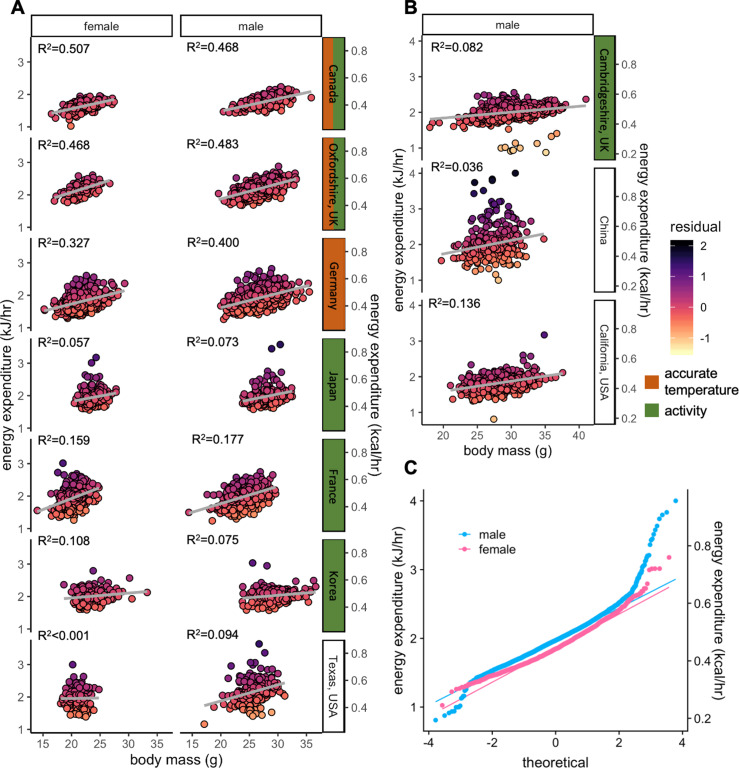
Variation in energy expenditure for WT female and male mice.Plots of the EE vs total mass showing the quality of the fit (R2 values) and shaded by residual values—the deviation from predicted values for each of the 9358 mice (6469 males and 2889 females). For the seven sites studying both sexes, the R2 values were similar between female and male mice (+/- 9%). Sites with accurate temperature covariate tended to have larger R2 values (A). R2 at the 3 sites reporting only data from male mice (B). A modified quantile-quantile plot of male and female mice from the 7 sites studying both sexes (C).